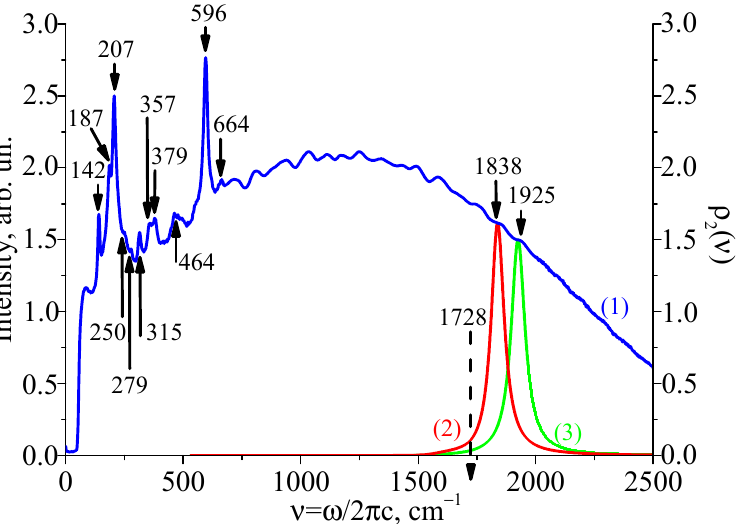
Figure 3. Comparison of the spectral Raman intensity of the LiTaO 3 :Cr(0.2):Nd(0.45 wt%) crystal (curve 1) in the overtone region with the calculated dependences of the density of two-phonon states ρ 2 ( ν ) (curves 2 and 3).